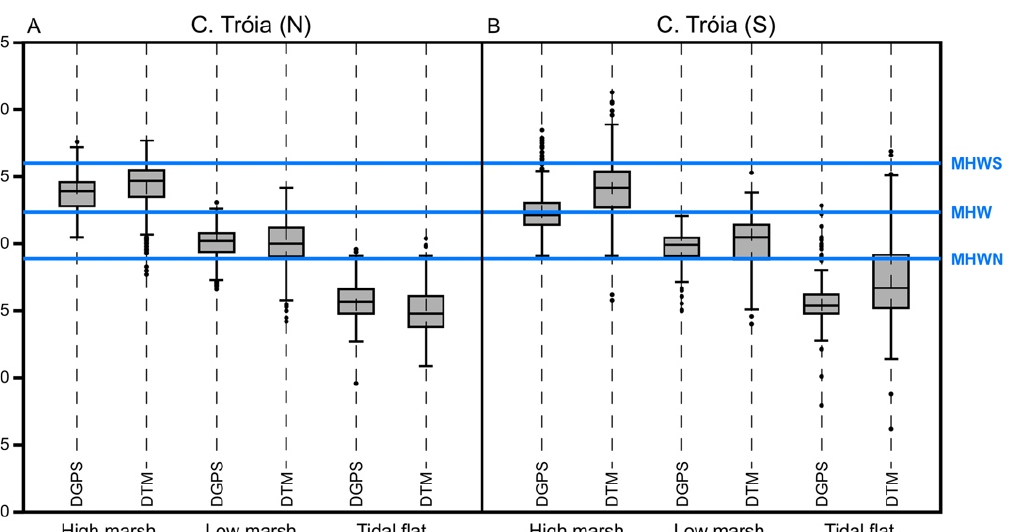
Table 3. RMSE and L.E. of C. Tróia (N) and (S) salt marshes DTM. C. Tróia (N) Global Dune